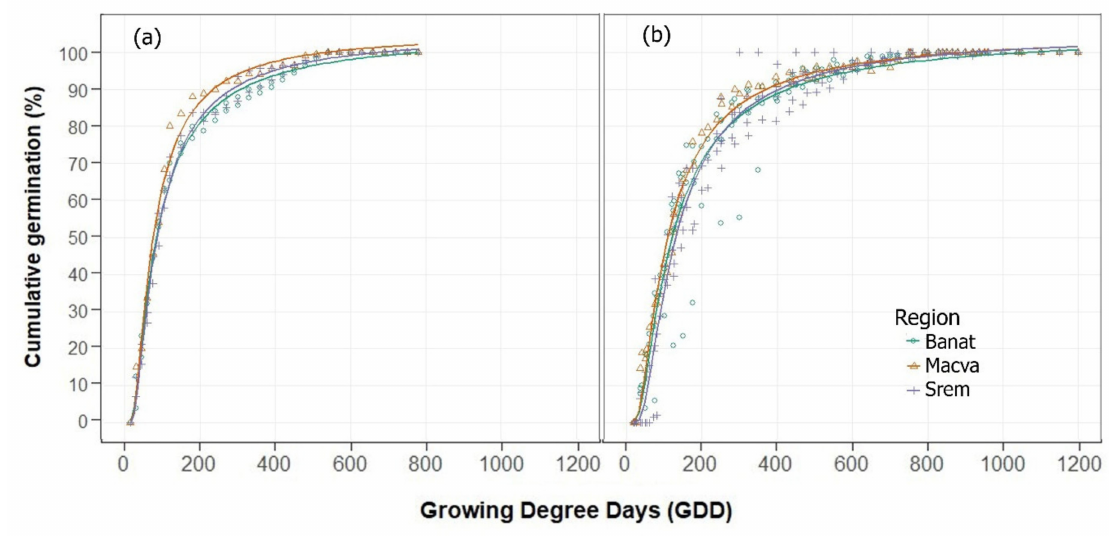
Figure 3. Cumulative germination (%) of 26 populations of Cuscuta campestris over growing degree days (GDD) by regions (Banat, Srem, Macva, and Belgrade) depending on ( a ) light and ( b ) no light.